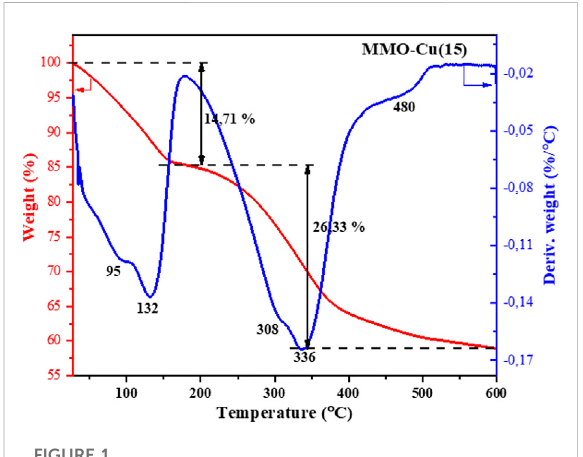
FIGURE 1 TGA and DTG spectra for the MMO-Cu(15) sample.